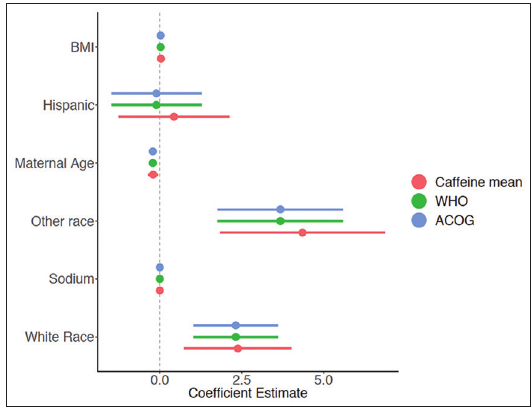
Figure 2: Regression Coefficients of Other Variable Effects on Telomere Length Stratified by Cutoff Point for Caffeine (Sample Mean, WHO Recommendation, and ACOG